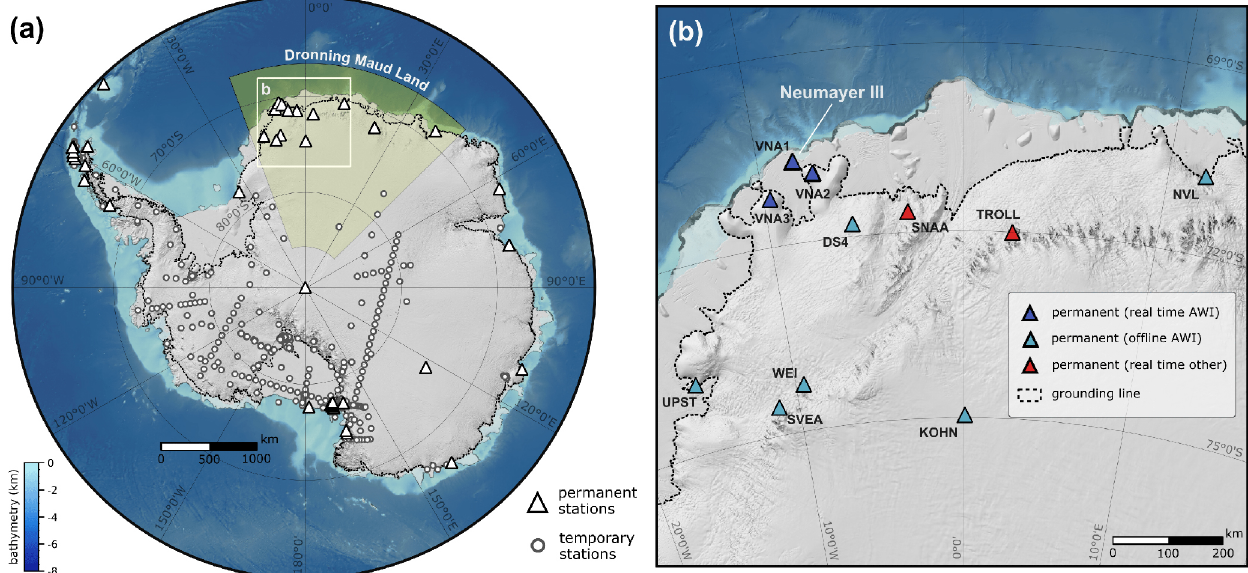
Figure 1. (a) Overview of permanent and temporary seismic station distribution in Antarctica (station locations obtained from IRIS GMAP, 2022). Panel (b) shows the distribution of real-time and offline permanent stations operated by the Alfred Wegener Institute (AWI) and others in western Dronning Maud Land. Note that the majority of temporary stations in (a) were installed by IRIS PASSCAL and that there are potentially more seismic stations in Antarctica whose locations are either not published or for which we do not have access to the